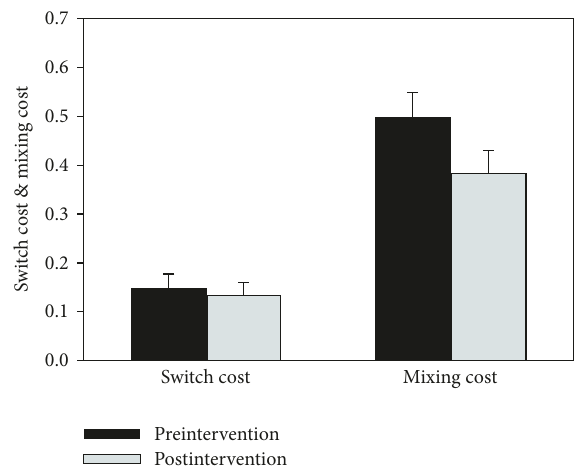
Figure 4: Mean switch cost [ ( RT Switch − RT Repeat )/ RT Repeat ] and mixing cost [ ( RT Mixed − RT Pure )/ RT Pure ] for the ASD intervention group on the task switching test, shown separately for each trial type (switch and repetition), block type (pure and mixed), and timepoint (before and after intervention). Error bars represent standard error of the